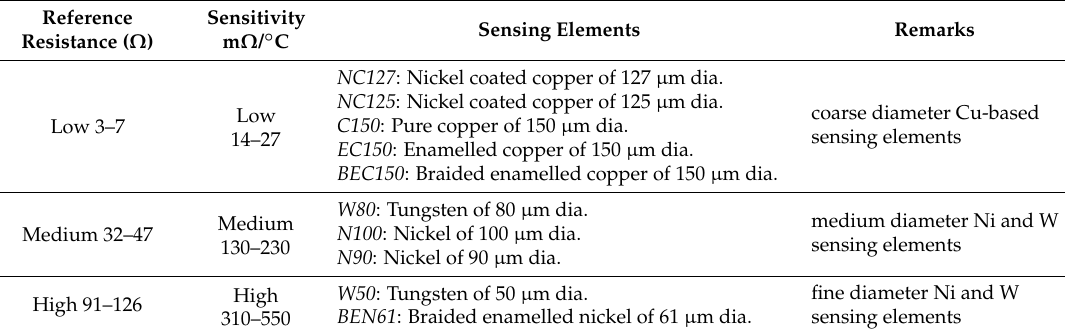
Table 1. Classification of TSF in terms of reference resistance and